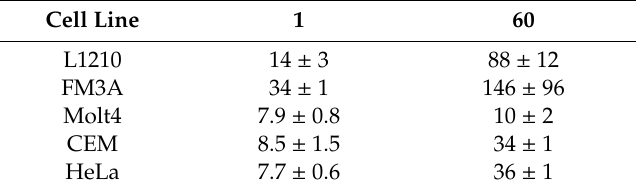
Table 19. Comparison of the IC 50 values of 1 and 60 against the murine leukemia L1210, murine mammary carcinoma FM3A, human T-leukemia Molt / 4 and CEM, and human cervix carcinoma HeLa cancer cells (IC 50 values in µ M).